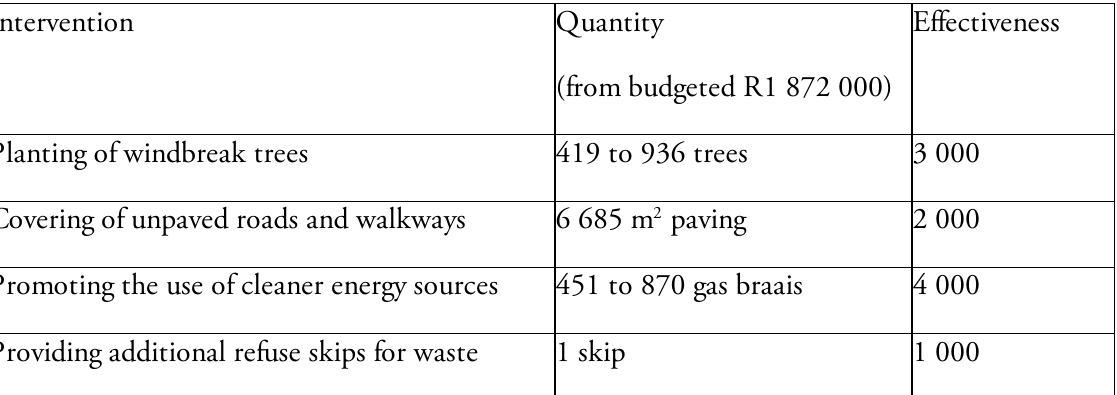
Table 13: Perceived ordinal effectiveness of specified PM10 reduction interventions Intervention